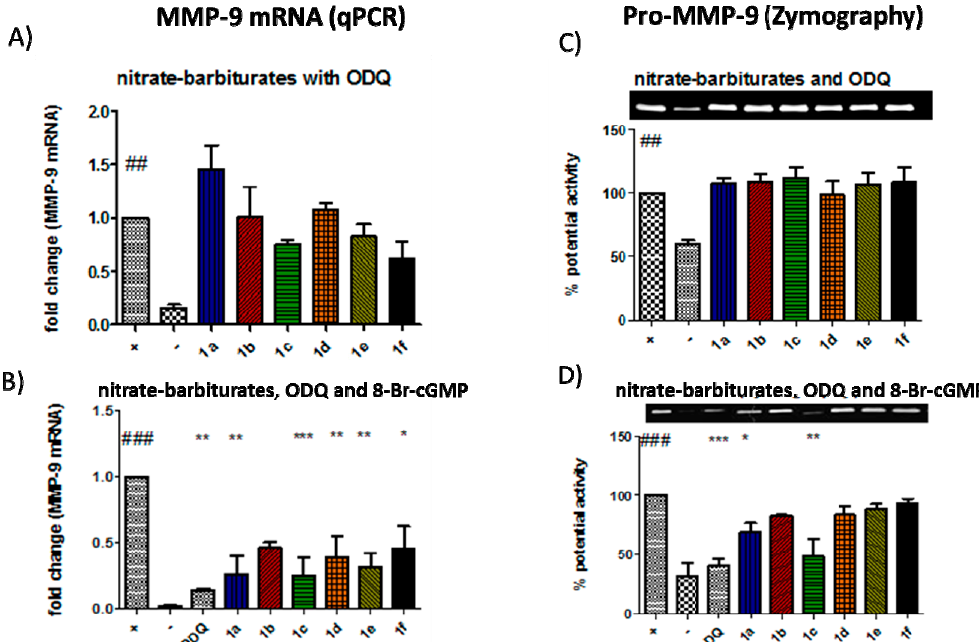
Figure 6. Barbiturate-nitrate hybrids inhibit MMP-9 via a soluble guanylate-cyclase-dependent pathway. ( A ) there was a significant up-regulation of the MMP-9 gene when inducing Caco-2 cells with the pro-inflammatory cytokines. When cells were activated in the presence of ODQ (0.05 µ M), this resulted in a reversion of MMP-9 mRNA levels in barbiturate-nitrate hybrid-treated cells. ( B ) Exogenously added 8-bromo-cGMP restored the e ff ect of ODQ (0.5 µ M). These results correlated with the pro-MMP-9 protein activity as shown by zymography ( C , D ) ## p < 0.01 vs. unstimulated Caco-2 cells (negative control); ### p < 0.001 vs. negative control; * p < 0.05 vs. cytokine-stimulated Caco-2 cells (positive control); ** p < 0.01 vs. positive control; *** p < 0.001 vs. positive control.